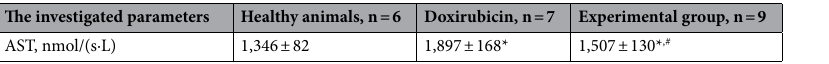
Table 2. The effect of the polyphenol concentrate on the activity of aspartate aminotransferase, (M ± m). *P < 0.05 compare to the value in the group of healthy animals. # P < 0.05 compare to the value in the group of control animals. Results presented are mean ± standard error of the mean.